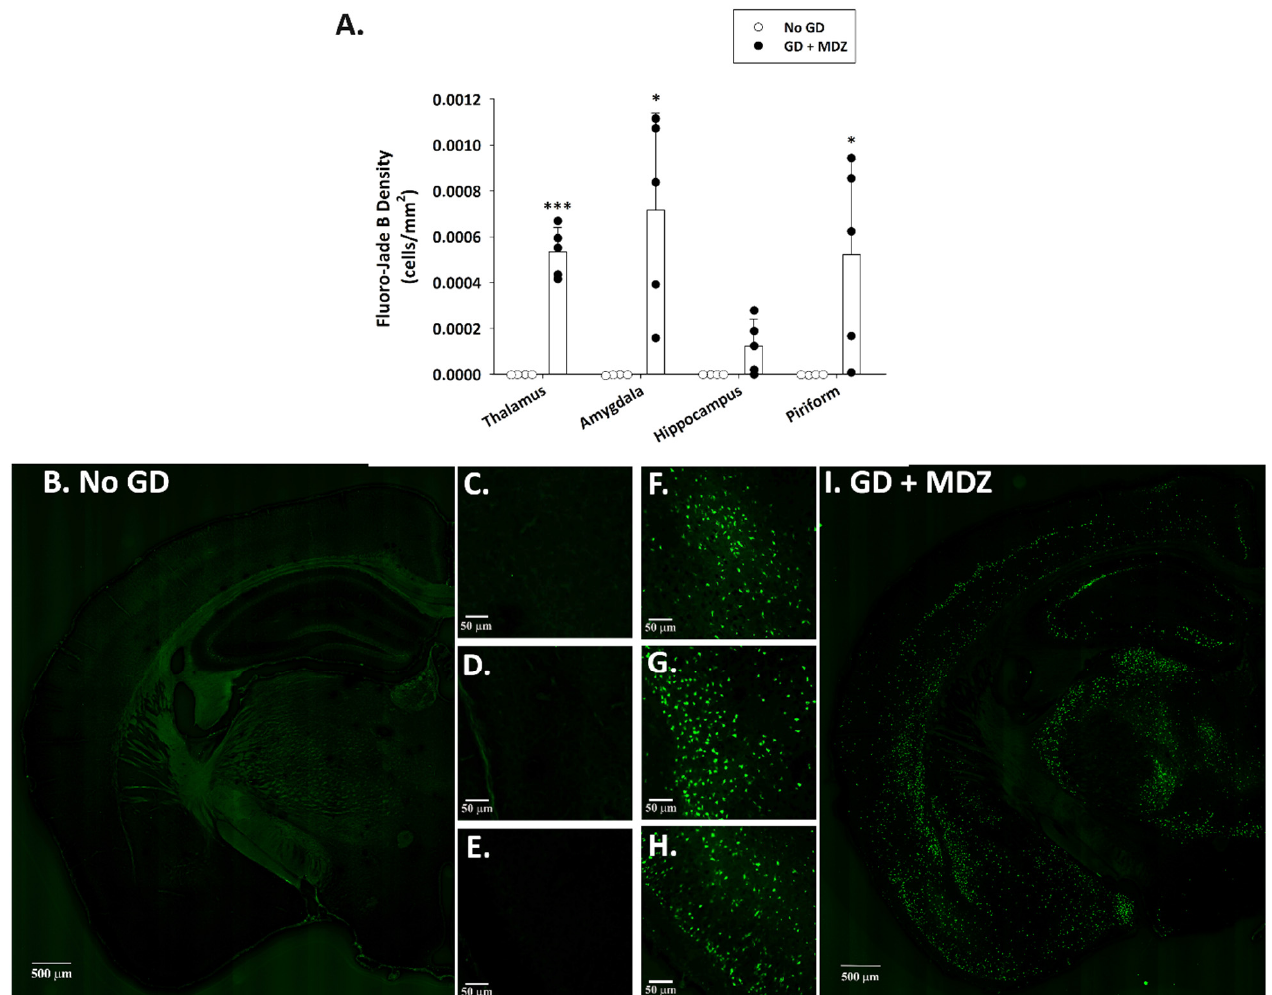
Figure 2. Effect of soman-induced status epilepticus and delayed midazolam (MDZ; 3 mg/kg; SC) treatment on neuronal cell degeneration in KIKO mice at 24 h after exposure. Soman-exposed (SC) KIKO mice were treated with midazolam at 15 min after seizure onset. At 24 h after saline or soman (GD) exposure, mice were perfused and brains were collected for staining with Fluoro-Jade B to visualize dying neurons. ( A ) Fluoro-Jade B-positive cell density was estimated in the thalamus, amygdala, hippocampus, and piriform cortex of GD-exposed mice given midazolam (GD + MDZ; n = 5), and no agent controls (No GD; n = 4). Representative images taken with a 0.40 NZ 10X objective are shown from ( B – E ) control mice and ( F – I ) soman-exposed mice. Close-ups of the ( C , F ) thalamus, ( D , G ) amygdala, and ( E , H ) piriform cortex are also shown. * p < 0.05, *** p < 0.001, compared to No GD control group.